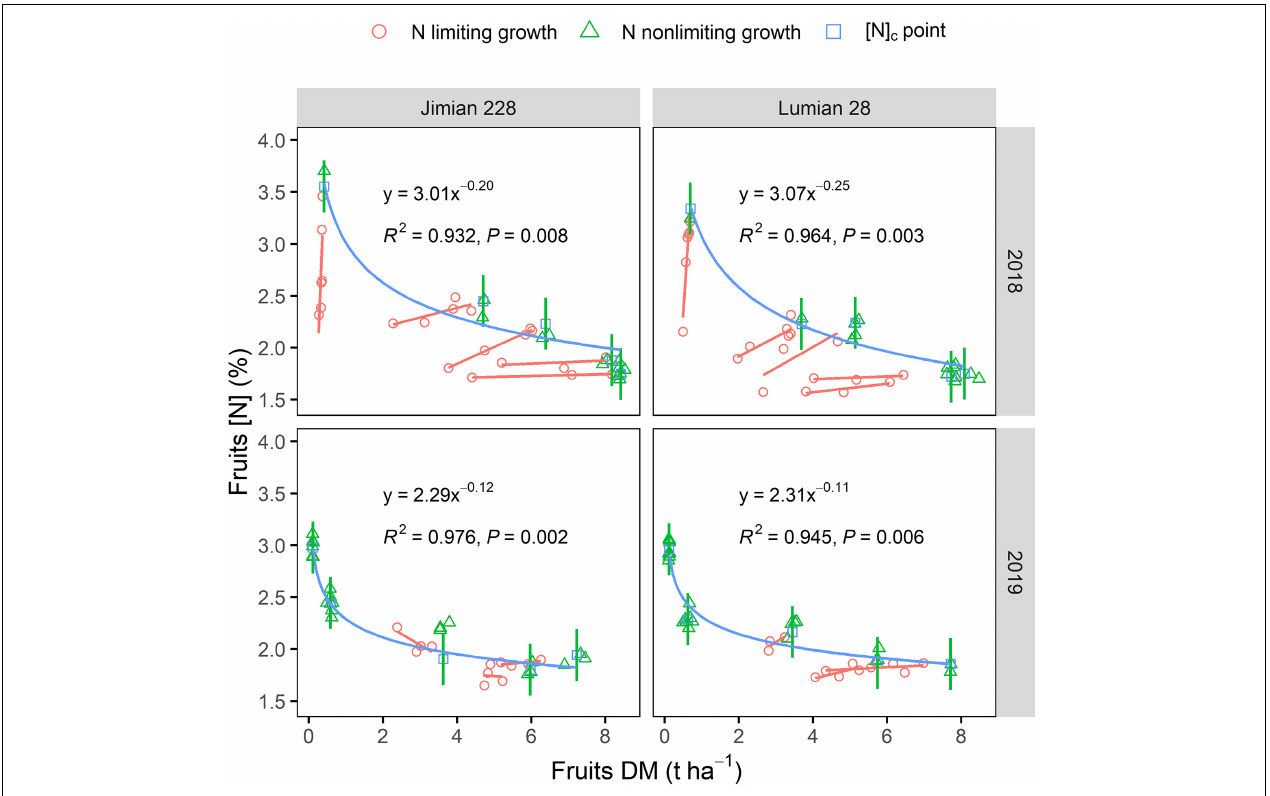
FIGURE 2 | Critical fruits N dilution curves for Jimian 228 and Lumian 28 in 2018 and 2019. DM, dry mass; [N], N concentration and [N] c , critical N concentration. Data show means of the three replicate plots. The red lines represent simple linear regression of N limiting growth points at each sampling date. The green lines represent the mean values of fruits dry mass by N non-limiting growth points at each sampling date. The blue lines represent the fitted critical N curves for cotton fruits using [N] c points. Two curves were not significantly different between cultivars in each year ( P = 0.3910 in 2018; P = 0.6605 in 2019) and were significantly different between years for Lumian 28 ( P = 0.0052) based on ANCOVA. The calculation for the critical N dilution point is shown in the section “Materials and